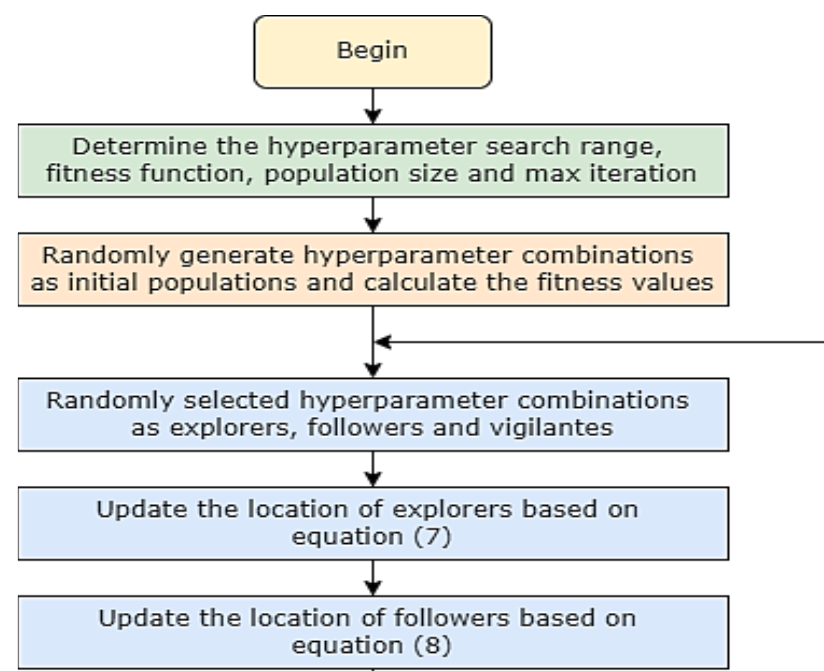
Table 1. Description of regression data sets.